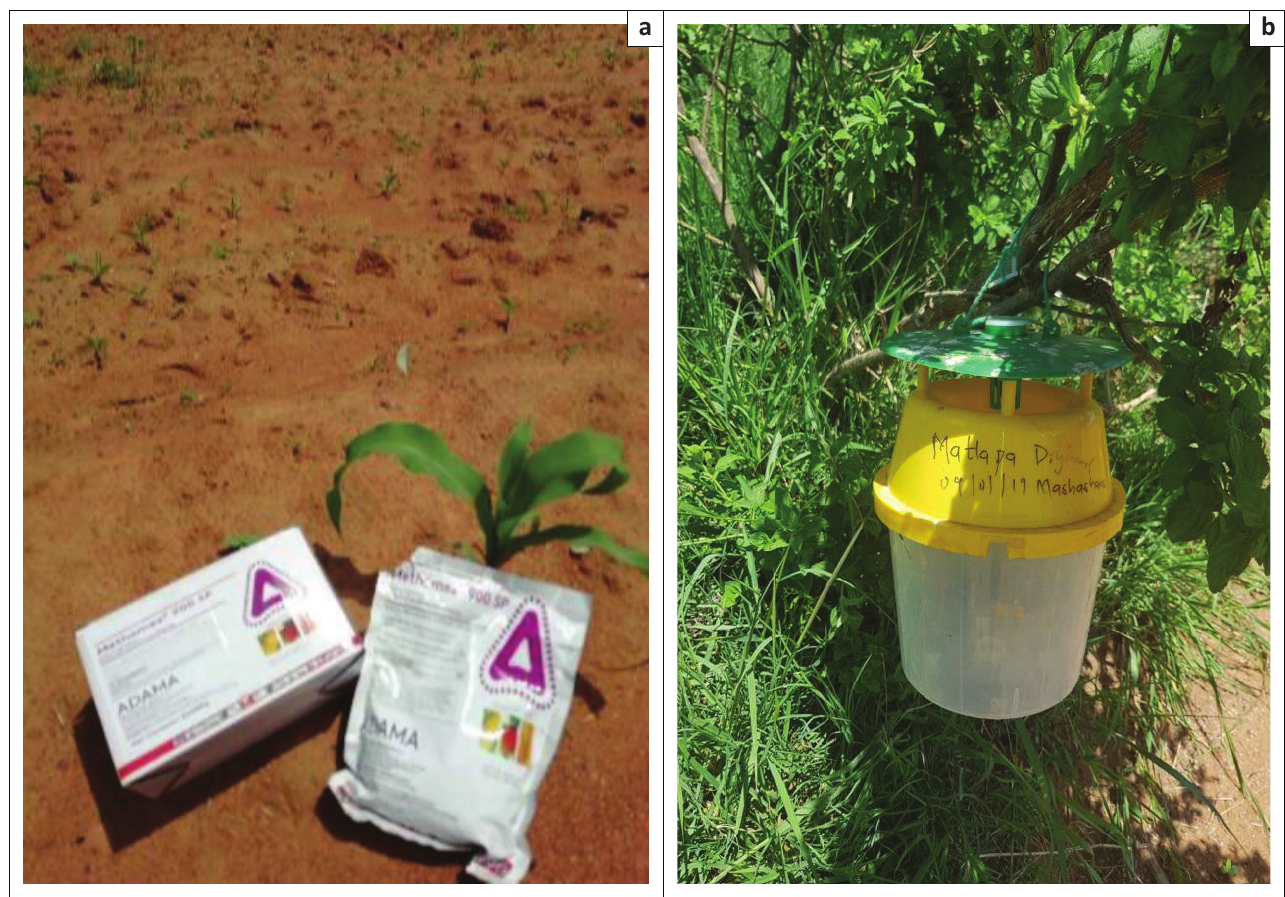
Source : Photos taken by Mankwana Christina